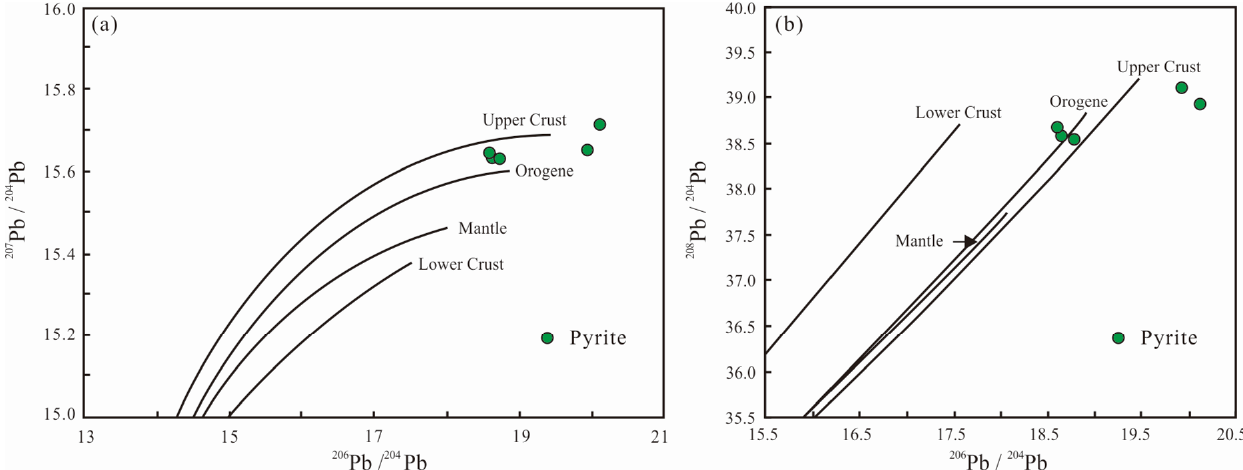
Figure 11. Lead isotopic compositions of pyrite from the Weizigou deposit (modified after Zartman and Doe, [107]). ( a ) 206 Pb/ 204 Pb- 207 Pb/ 204 Pb; ( b ) 206 Pb/ 204 Pb- 208 Pb/ 204